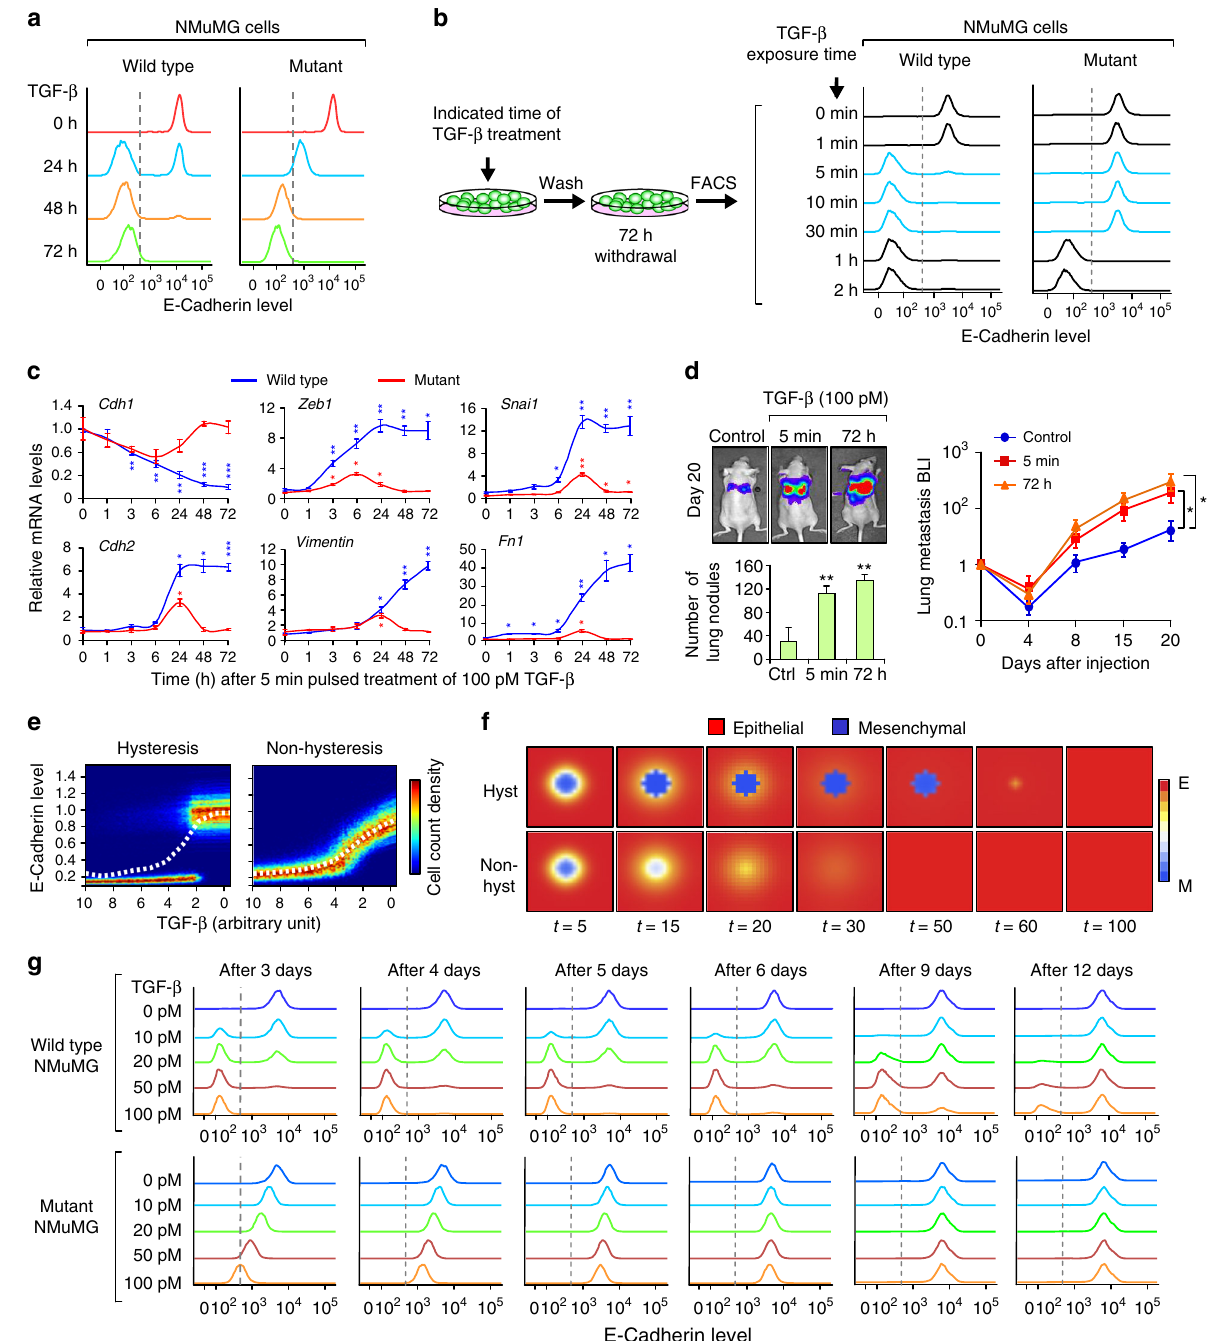
Fig. 3 Dynamic analysis of the hysteretic and non-hysteretic EMT in NMuMG and EpRAS cells. a Analysis of the dynamic of EMT induction (100 pM TGF- β ) in wild type and mutant NMuMG cells by fl ow cytometry analysis of CDH1. The time represents the duration of treatment at the moment of measurement. b Minimum exposure time of 100 pM TGF- β required to induce EMT in wild type and mutant NMuMG cells by fl ow cytometry analysis of CDH1. The time represents the duration of the transient treatment, with the measurement done 72 h post-induction for all conditions. c qRT-PCR analysis of EMT marker genes at the indicated times after a 5 min pulse treatment of 100 pM TGF- β . n = 3 technical replicates. d Quanti fi cation of lung metastatic nodules and bioluminescence imaging (BLI) quanti fi cation of the metastatic growth of wild type EpRAS cells in the lungs after tail vein (T.V.) injection of 20,000 cells in Ncr-nu/nu mice ( n = 6 mice). Cells were untreated (control) or treated with 100 pM TGF- β for the indicated time. e Steady-state simulation of CDH1 expression in mesenchymal-like cells after withdrawal of TGF- β . Heatmap graphs depict CDH1 expression at single cell level (color indicates cell count for a given CDH1 expression level) and dashed line represents CDH1 expression as the average of the population. f Simulation of EMT reversion in mesenchymal-like cell populations by modeling CDH1 expression with or without hysteresis. Red represents the epithelial cells (CDH1-high) and blue the mesenchymal cells (CDH1-low). g Flow cytometry analysis of the CDH1 expression showing the reversion kinetics in wild type versus mutant NMuMG cells. Cells were treated with indicated concentration of TGF- β for 72 h, after which TGF- β was withdrawn and cells allowed to revert for indicated duration. Data represent mean±SEM in c and d . * P < 0.05, ** P < 0.01, *** P < 0.005 by two-tailed Student ’ s t -test in c and